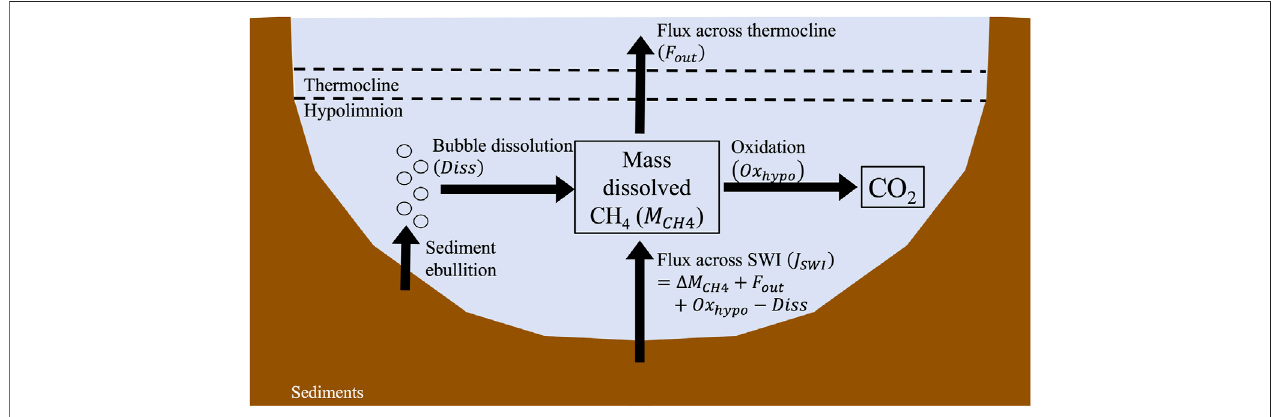
FIGURE 4 | Example mass balance model of a lake hypolimnion. Note arrows are not drawn to scale. See text for details ( Section 2.3